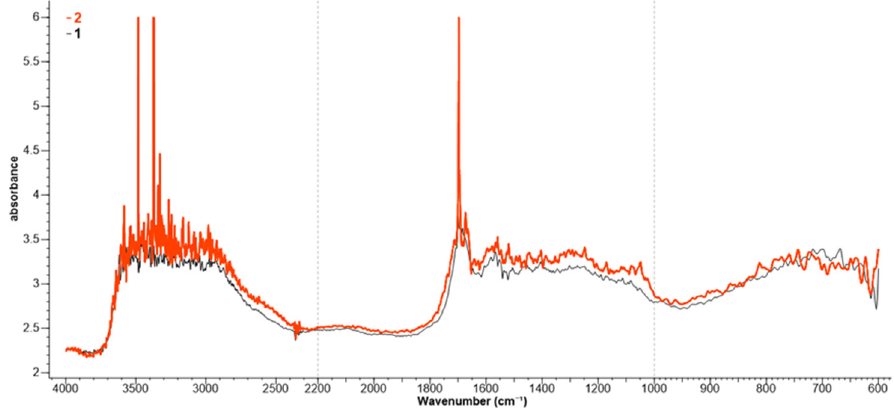
Figure 11. Characterization of the colors resulted after dyeing of the wool with functionalized betalains: ( a ) CIEL* a * b * measurements; ( b ) color strength, K/S.